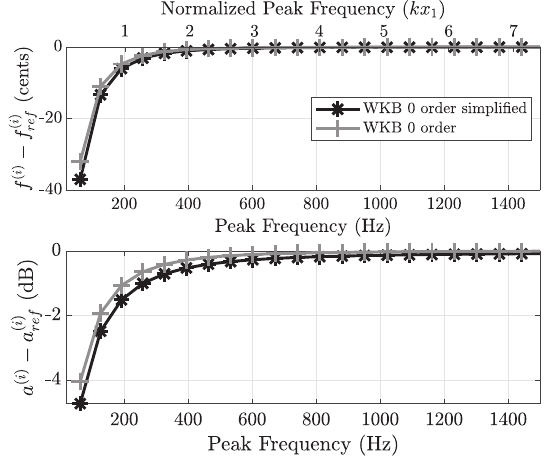
Figure 8. Difference between the resonance parameters of the WKB simulations at the zeroth order (complete and simpli fi ed) to those of a reference impedance for a simpli fi ed baritone saxophone: top : frequencies and bottom : magnitudes. In both simulations, the second order approximation is used for the viscothermal